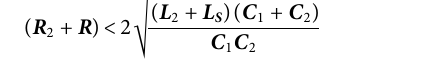
horizontal line of each “ ladder ” represents a complete single- arc burning process, and the blue-dotted waveform in Figure 2 is a complete single-arc waveform.